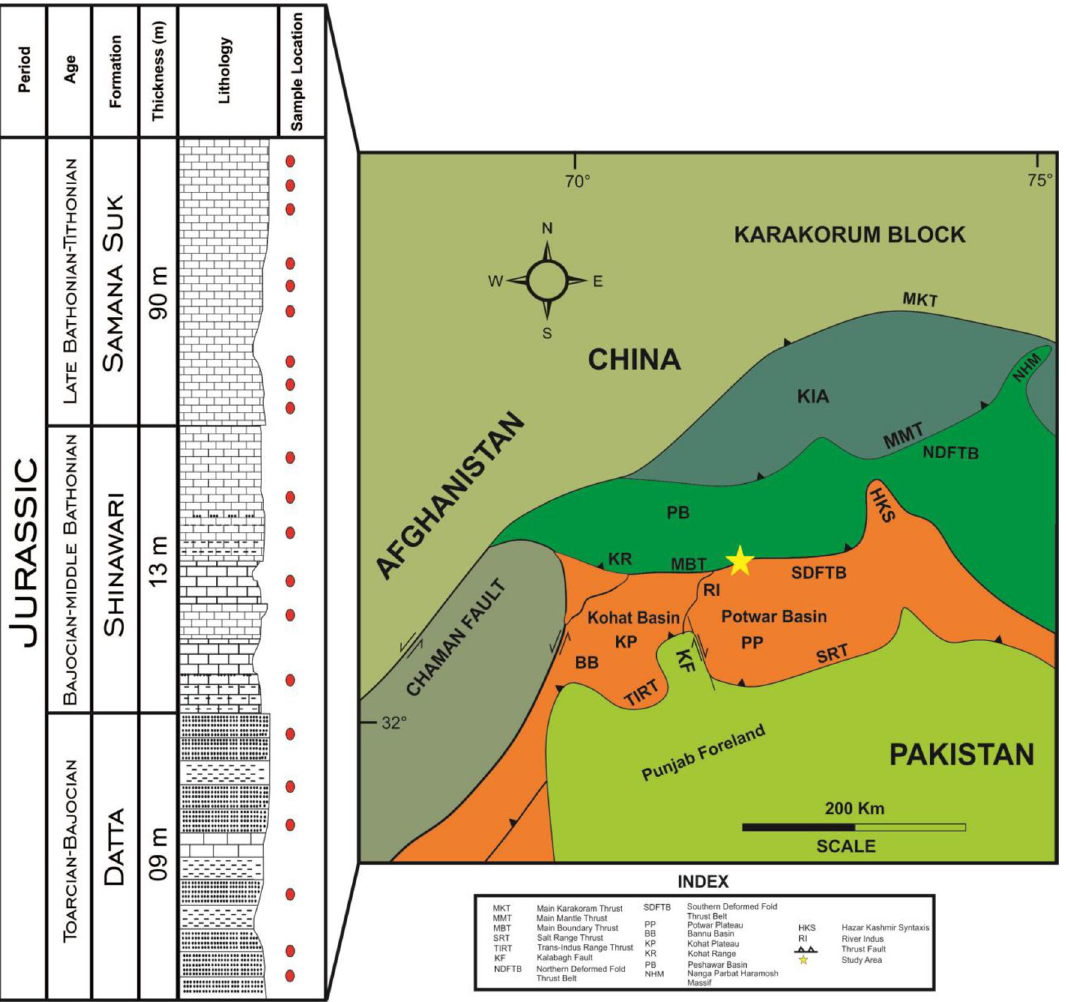
Fig. 1 Tectonic map of Pakistan (modified after Banks and Warburton 1986; Kazmi and Rana 1982) and lithological log of the Datta, Shinawari and Samana Suk formations in the study area at the left